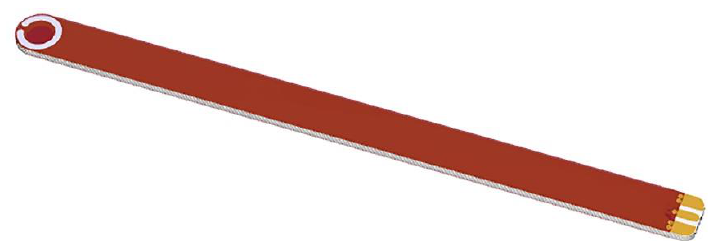
Figure 1. A 3D model of the designed Near-Field Probe.